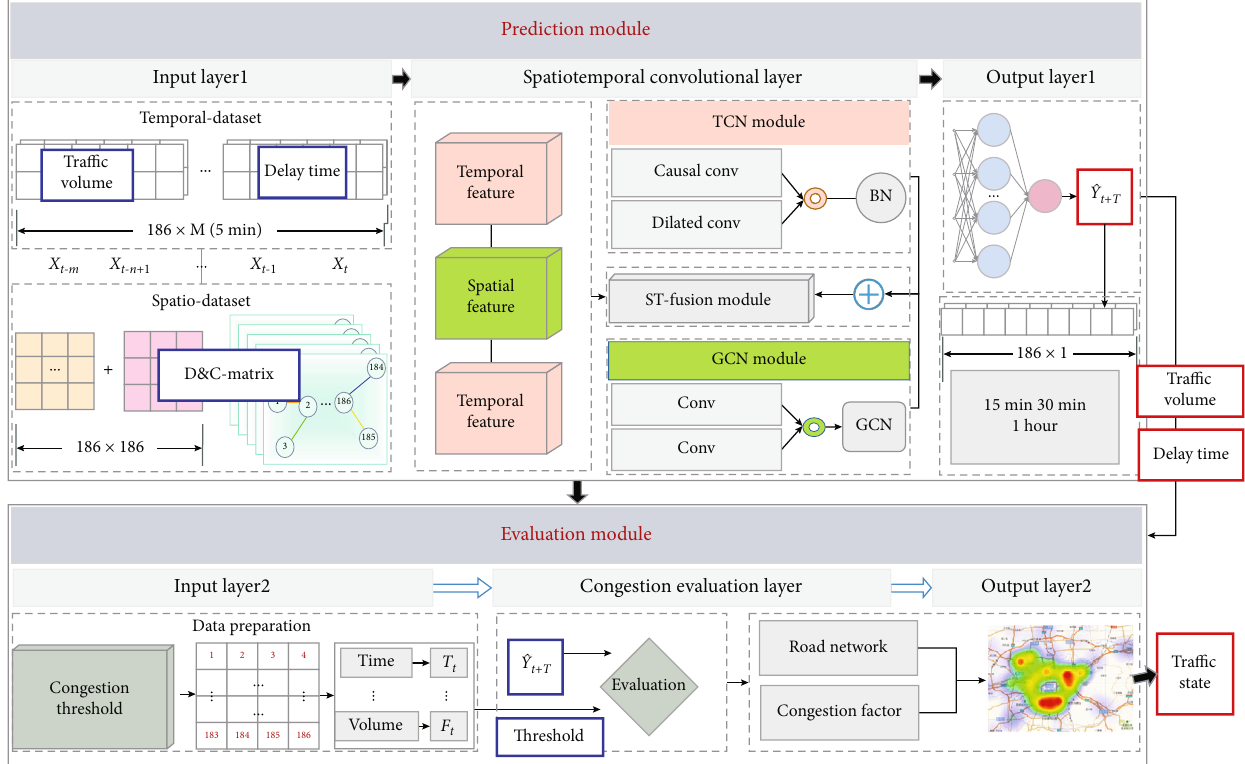
Figure 6: CPT-DF network: congestion prediction on toll-gates using deep learning and fuzzy evaluation. The blue line boxes represent the input values of the prediction module and the evaluation module, respectively, the red line boxes represent the output values, and the output value of the prediction module is also one of the input values of the evaluation